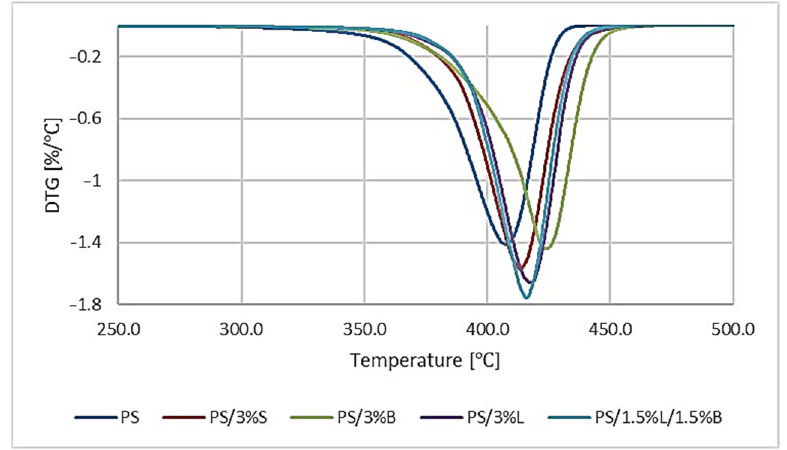
( d ) ( e ) Figure 6. SEM micrographs with an EDS attachment of PS polymer and composites based on PS: ( a ) PS, ( b ) PS/3%S, ( c ) PS/3%B, ( d ) PS/3%L, ( e ) PS/1.5%L/1.5%B.